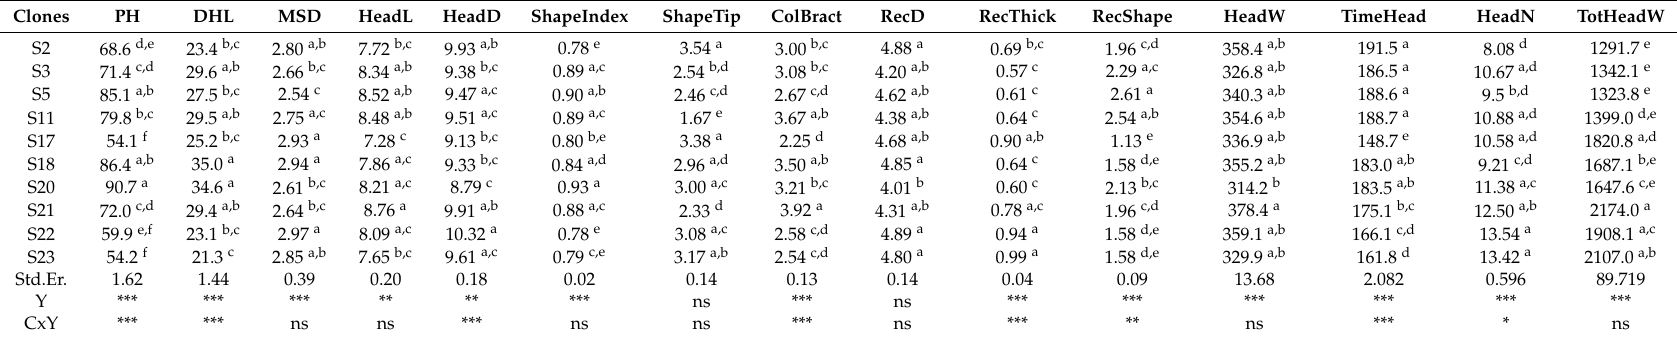
Table 3. Differences in some morphological traits (means over two years) of the 10 Romanesco landraces analyzed. Plant height (PH, cm), distance between the youngest leaf on the main floral stem and the central flower-head (DHL, cm), stem diameter (MSD, cm), head length (HeadL, cm), head diameter (HeadD, cm), head shape (ShapeIndex), head tip shape (ShapeTip), bract colour (ColBract), diameter of the receptacle (RecD, cm), receptacle thickness (RecThick, cm), receptacle shape (RecShape), head weight (HeadW g), time of head maturity (TimeHead), total head number (HeadN), and total head weight (TotHeadW,